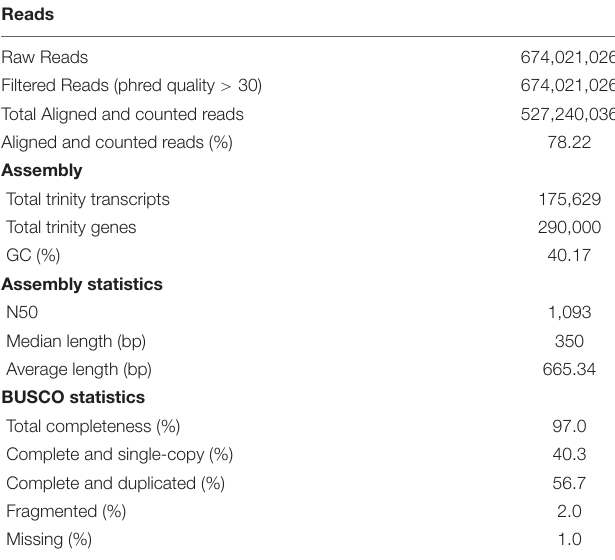
TABLE 1 | Assembly statistics for whole body of Glyptonotus antarcticus